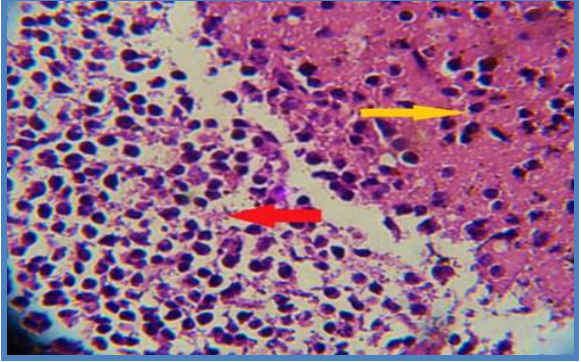
Figure, 14: Micrograph of goat group B mononucular cells infiltration (brown arrow) with aggregation of lymphocyte around blood vessel in the incision (red arrow) at 30 th day postoperative (H and E 40